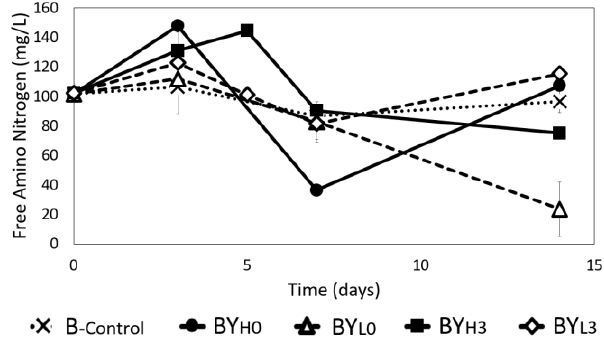
Figure 8. Changes in free amino nitrogen (FAN) concentration during 14 days of cultivation using K. intermedius mono-(B -control ) and co-cultures with D. bruxellensis at 30 ◦ C. D. bruxellensis was added simultaneously at concentrations of 10 6 CFU/mL (BY H0 ) and 10 3 CFU/mL (BY L0 ) and sequentially at 10 6 CFU/mL (BY H3 ) and 10 3 CFU/mL (BY L3 ).